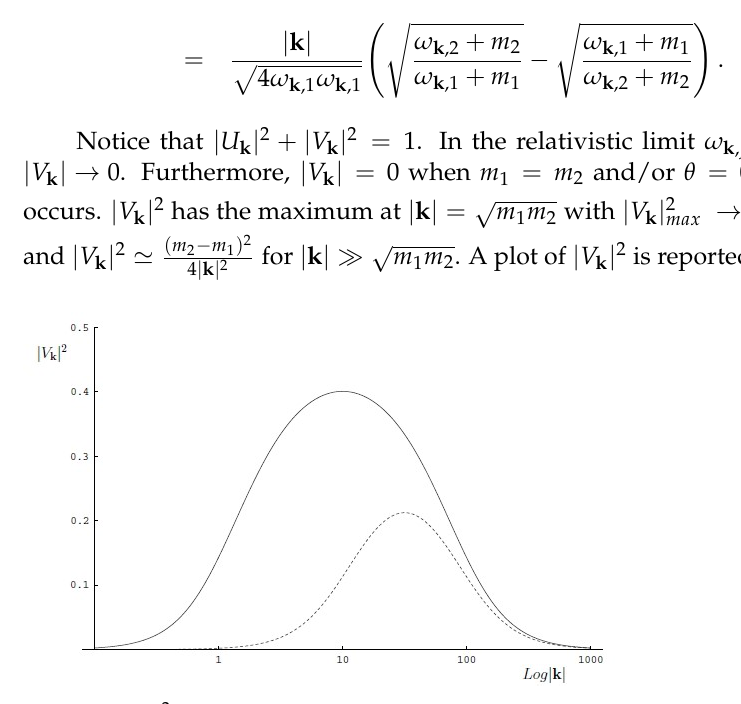
Figure 1. | V k | 2 for sample values of masses. The solid line corresponds to m 1 = 1 and m 2 = 100, while the dashed line corresponds to m 1 = 10 and m 2 = 100